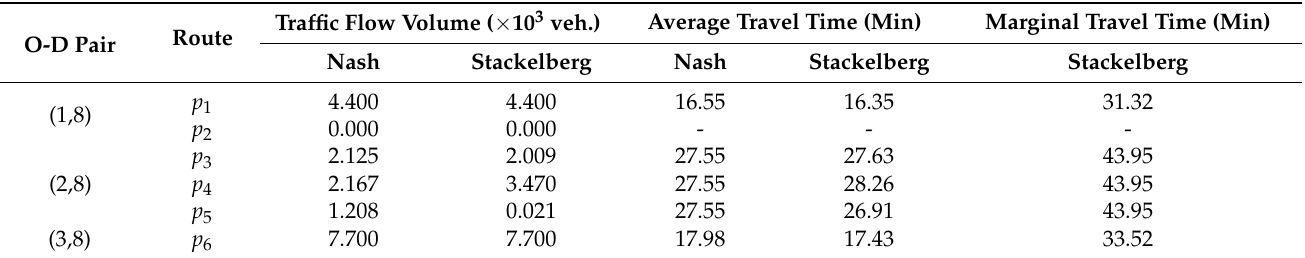
Table 9. Results of optimization with the Nash and Stackelberg approaches for movement routes in scenario #3.